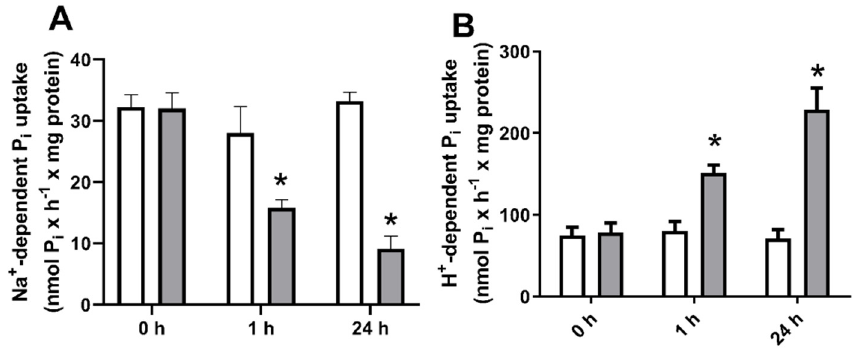
Figure 9. Effect of high Pi Na + -dependent or H + -dependent Pi transport for short (1 h) or long (24 h) Pi-exposure of MDA-MB-231 cells. MDA-MB-231 cells were treated with 1 (white bars) or 8 mM Pi (grey bars) for different times of exposure (0, 1 and 24 h). Na + -dependent ( A ) or H + -dependent ( B ) Pi uptake was done for 1 h, as described in Section 4. The results are mean ± SE of at least three independent biological samples. * p < 0.05 indicates changes significantly different, as assessed by ANOVA followed by Tukey’s multiple comparison test.